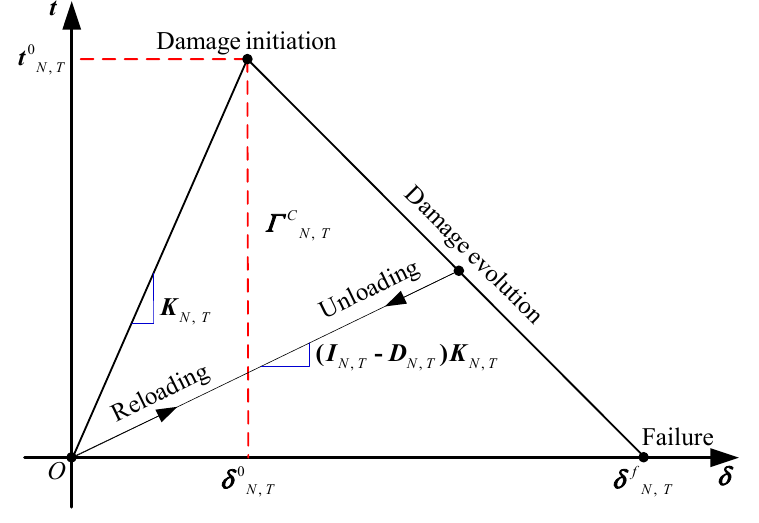
Figure 4. Bilinear constitutive model in the mixed mode.